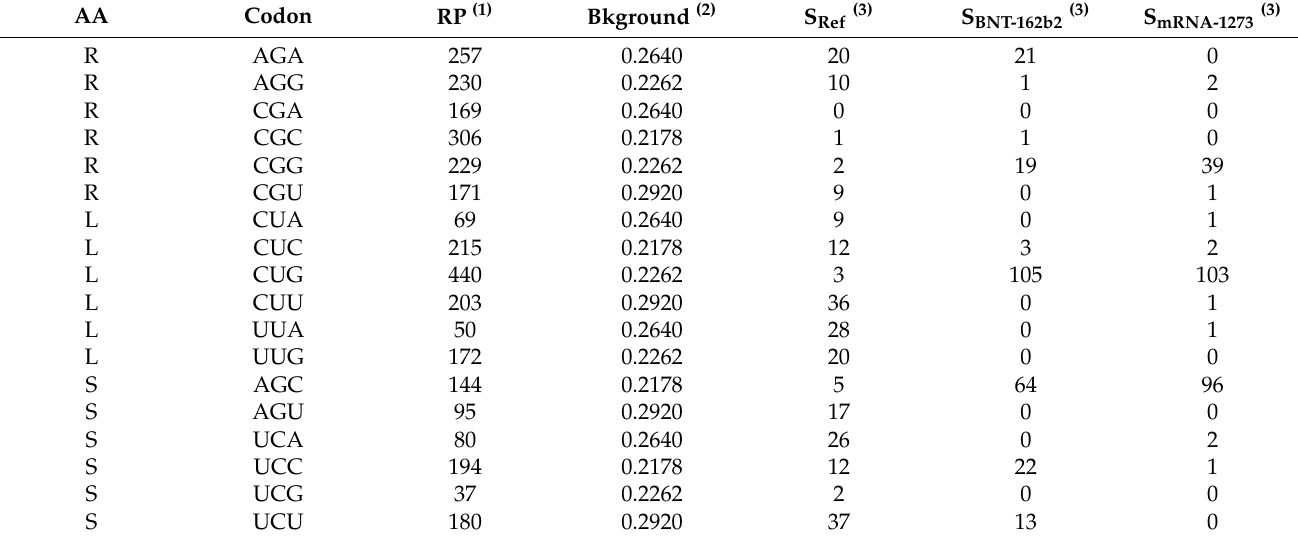
Table 1. Optimization of compound codon families in the two mRNA